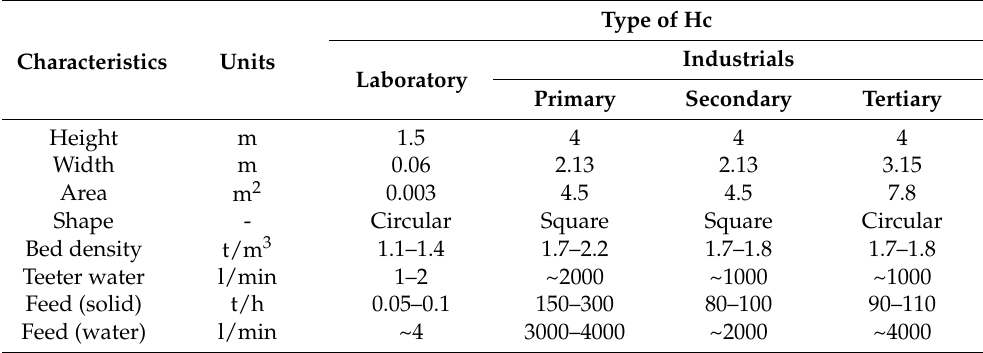
Table 1. Operating conditions of experiments on industrial and laboratory set-ups.